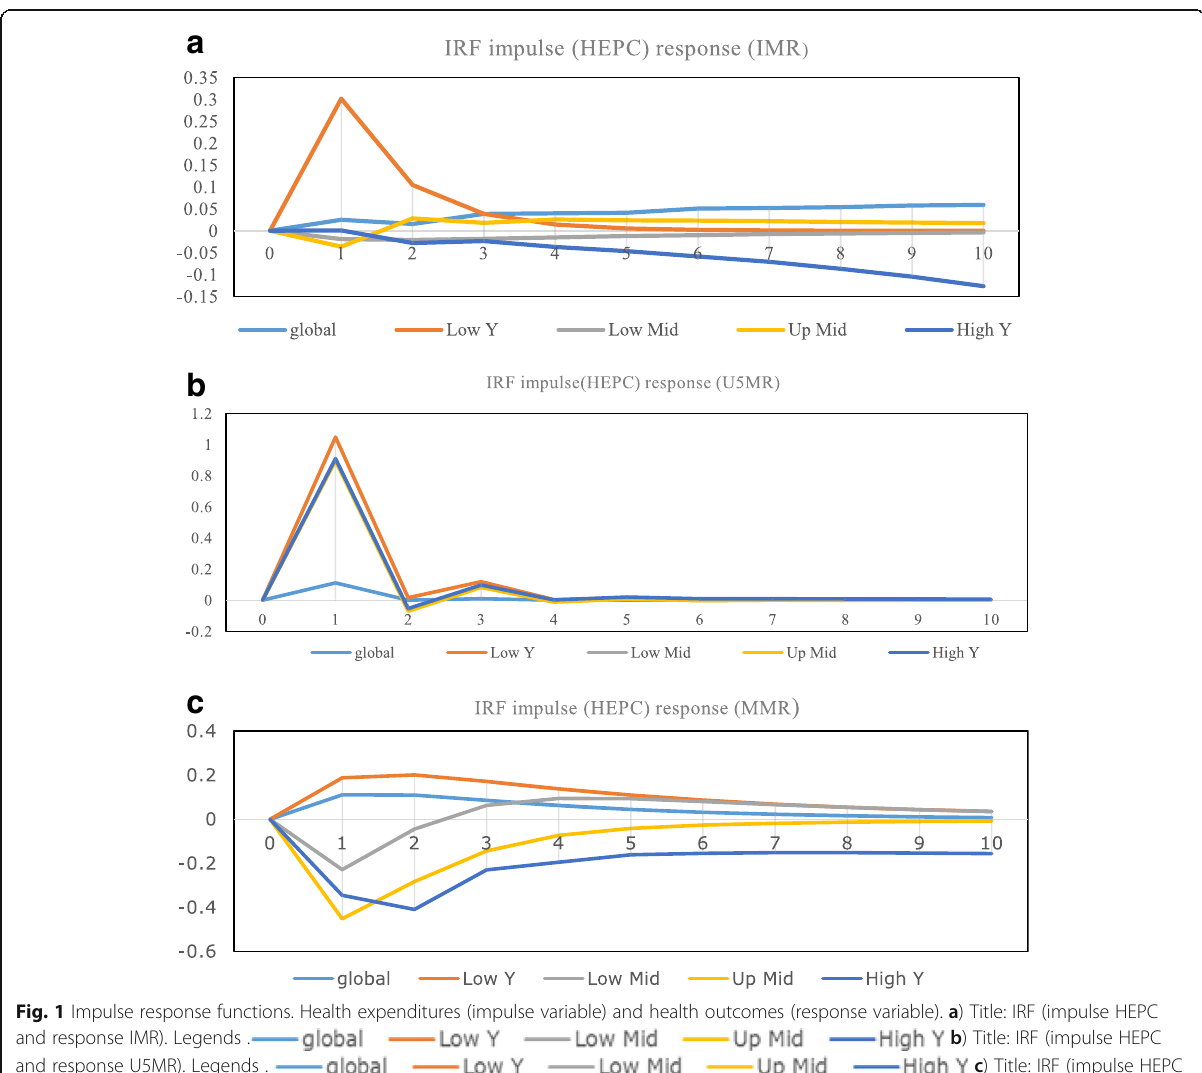
Fig. 1 Impulse response functions. Health expenditures (impulse variable) and health outcomes (response variable). a ) Title: IRF (impulse HEPC and response IMR). Legends